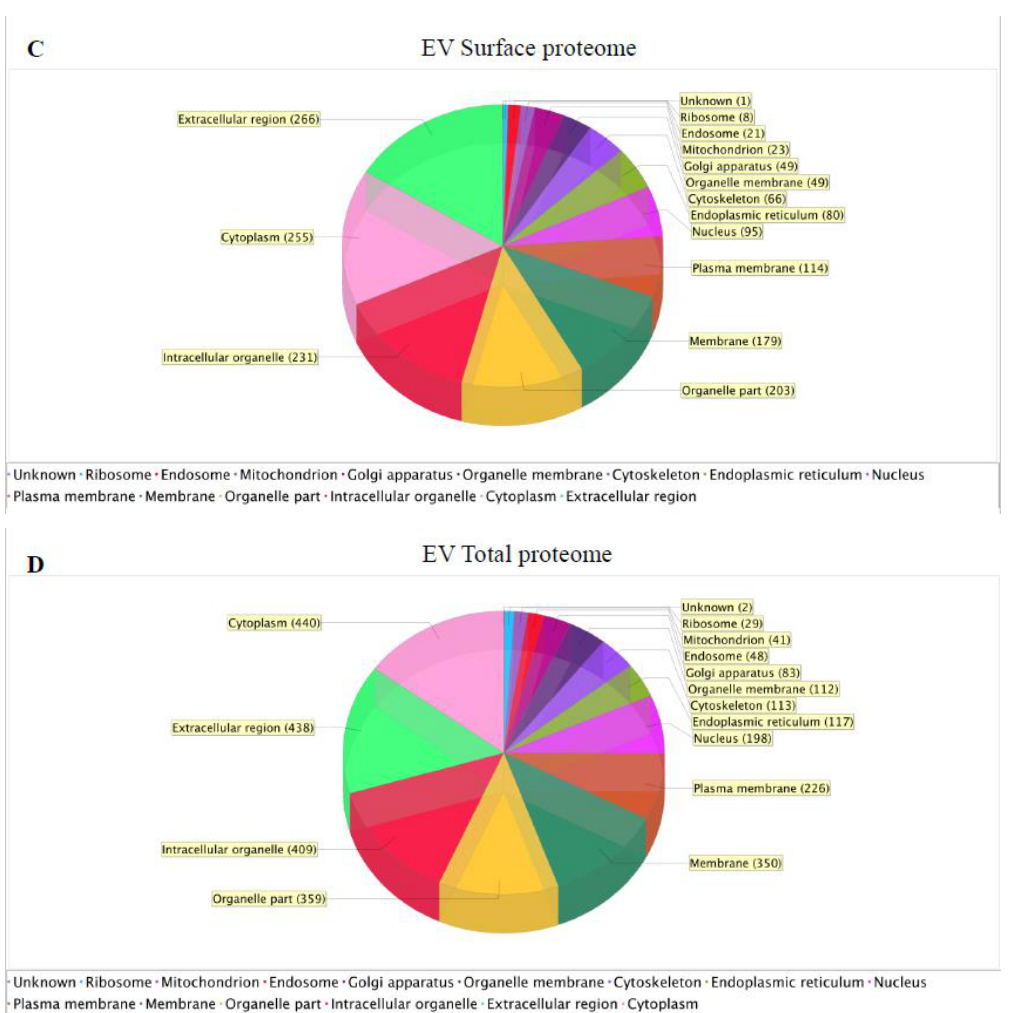
Figure 1. Extracellular vesicle (EV)-specific markers in the surface and total proteomes of human brain microvascular endothelial cells (HBMEC)-derived EVs. Venn diagram showing the overlap between the HBMEC-EV surface proteome (283 proteins) ( A ) or the HBMEC-EV total proteome (501 proteins) ( B ) and the top 100 EV marker proteins from ExoCarta. Cellular component enrichment of the identified surface ( C ) and total ( D ) EV proteomes. The identified EV proteins were enriched for cellular component using the Scaffold software.